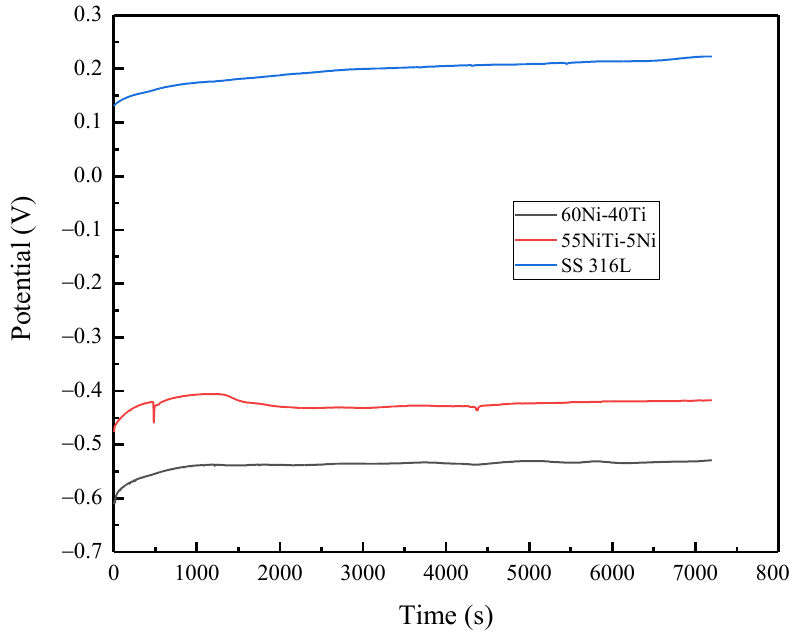
Figure 10. The open-circuit potential (OCP) of coatings and the substrate.